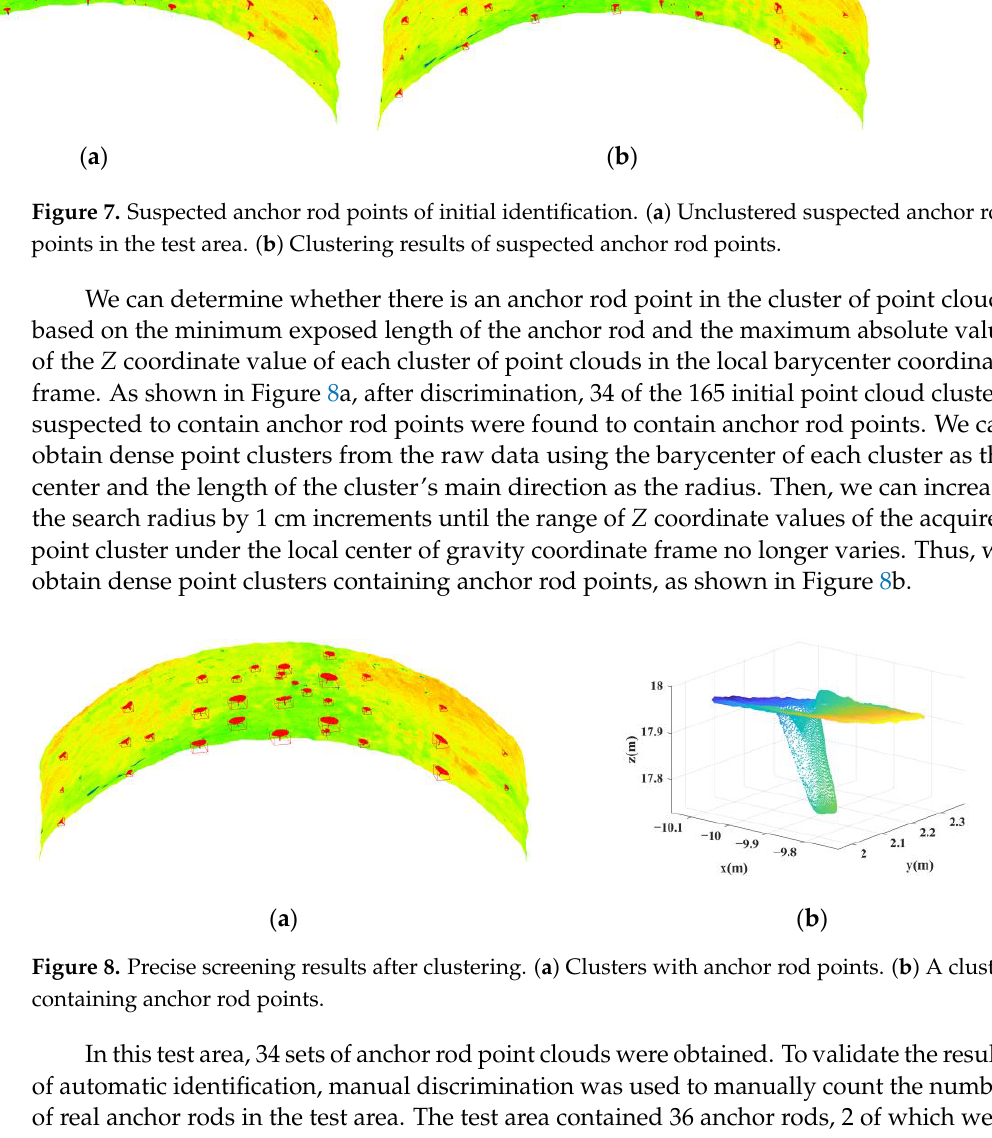
Figure 6. A neighborhood containing anchor rod points. ( a ) Initial point cloud after downsam- pling. ( b ) Preliminary identification results; points colored in blue are suspected anchor rod points.